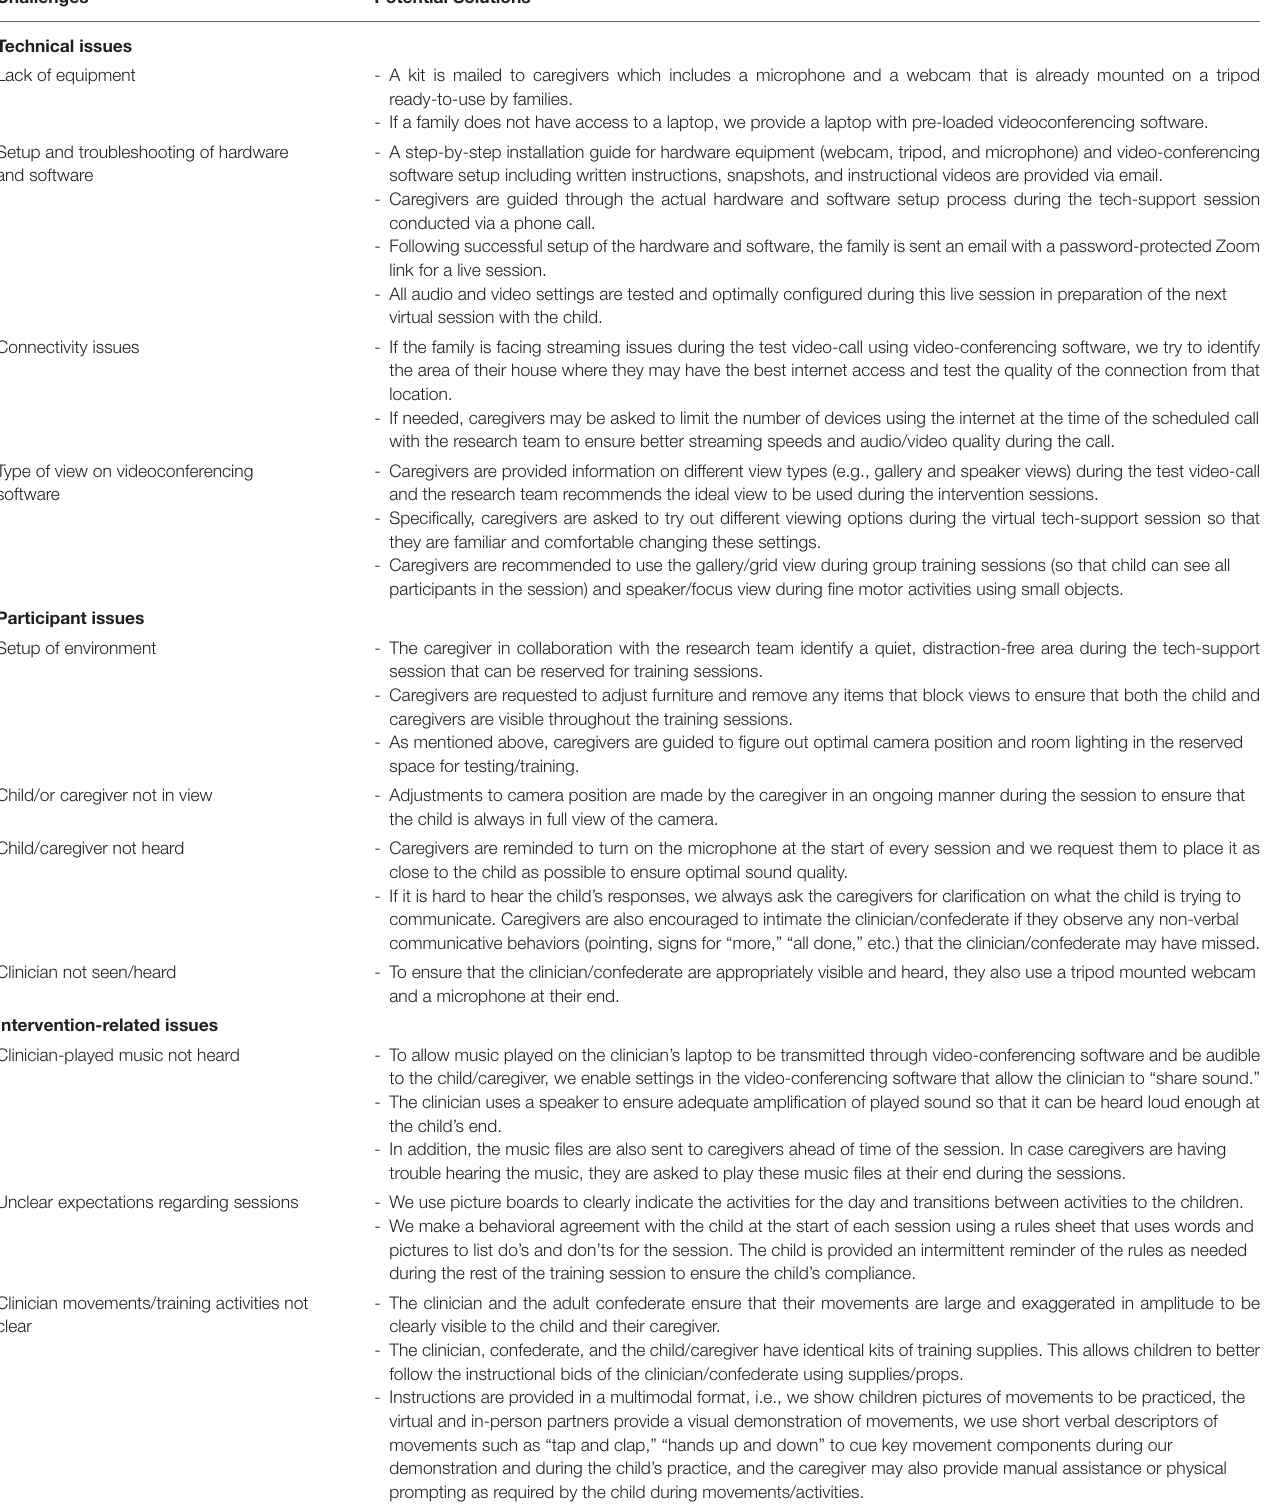
TABLE 1 | Challenges and potential solutions during telehealth